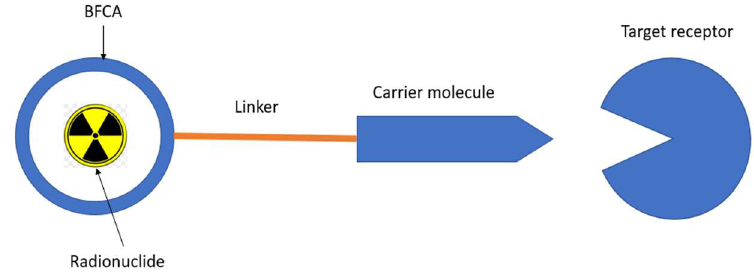
Figure 1. Ligand–BFCAs–radioisotope as a commonly designed radiopharmaceutical.